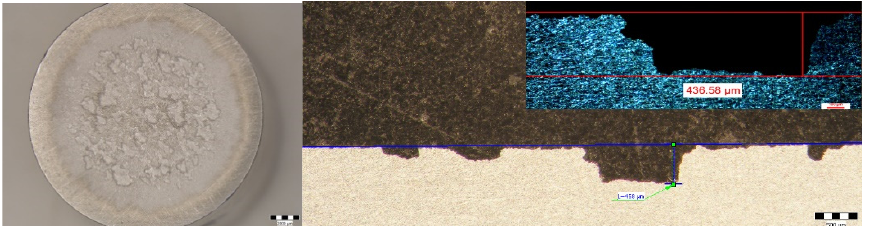
Figure 10. Appearance of macrostructural surfaces (left front section, parallel to the eroded surface, right in cross section, background optical microscope image, detailed stereomicroscope image) subjected to cavitation erosion of alloy 5083, in cast state .